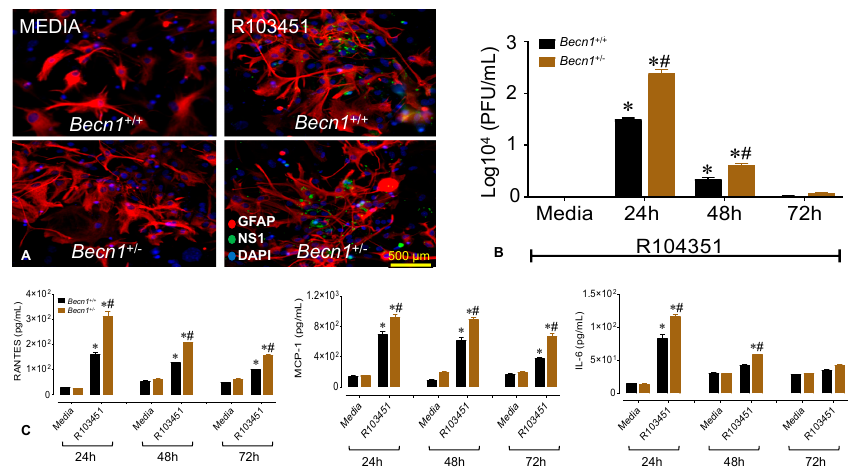
Figure 4. ZIKV infects mixed mouse glia and induces inflammatory molecules. ( A ) Representative immunofluorescent images of mouse mixed glia derived from Becn1 +/+ (top) and Becn1 +/ − (bottom) pups exposed to media (left) and infected with ZIKV (right). Cells were labeled with the antibody against Glial Fibrillary Acidic Protein (GFAP, red), the antibody against ZIKV NS1 (green), and 4 ′ ,6-diamidino-2-phenylindole (DAPI) was used to label nuclear DNA (blue). The images were acquired using an inverted fluorescence microscope with a 560 Axiovision camera and a assays at a dilution of 10 4 . The graph shows Becn1 +/+ glia in black bar and Becn1 +/ − glia in brown bar. ( C ) The secretions of regulated on activation, normal T cell expressed and secreted (RANTES),